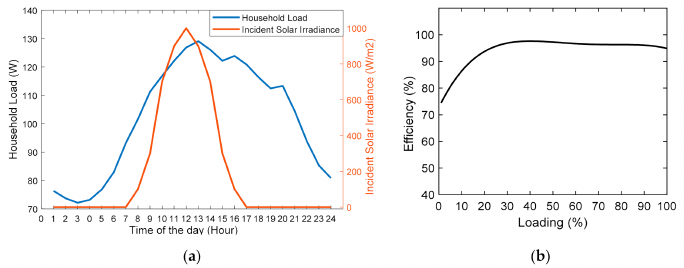
Figure 9. ( a ) Time-varying profile of the household load (left y-axis) and incident irradiance (right y-axis) ( b ) converter e ffi ciency vs. percentage loading